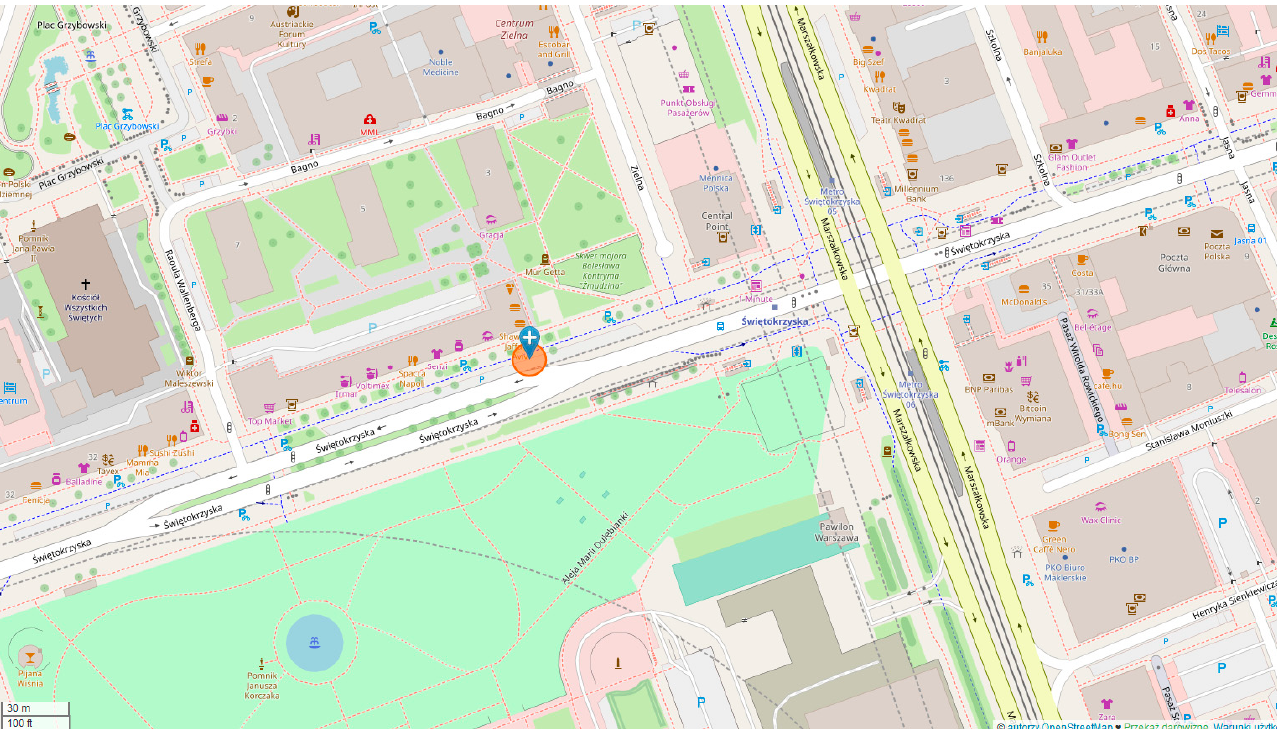
Figure 8. Location of the measuring station at Ś wi ę tokrzyska street (own study, based on www.openstreetmap.org accessed on 12 December